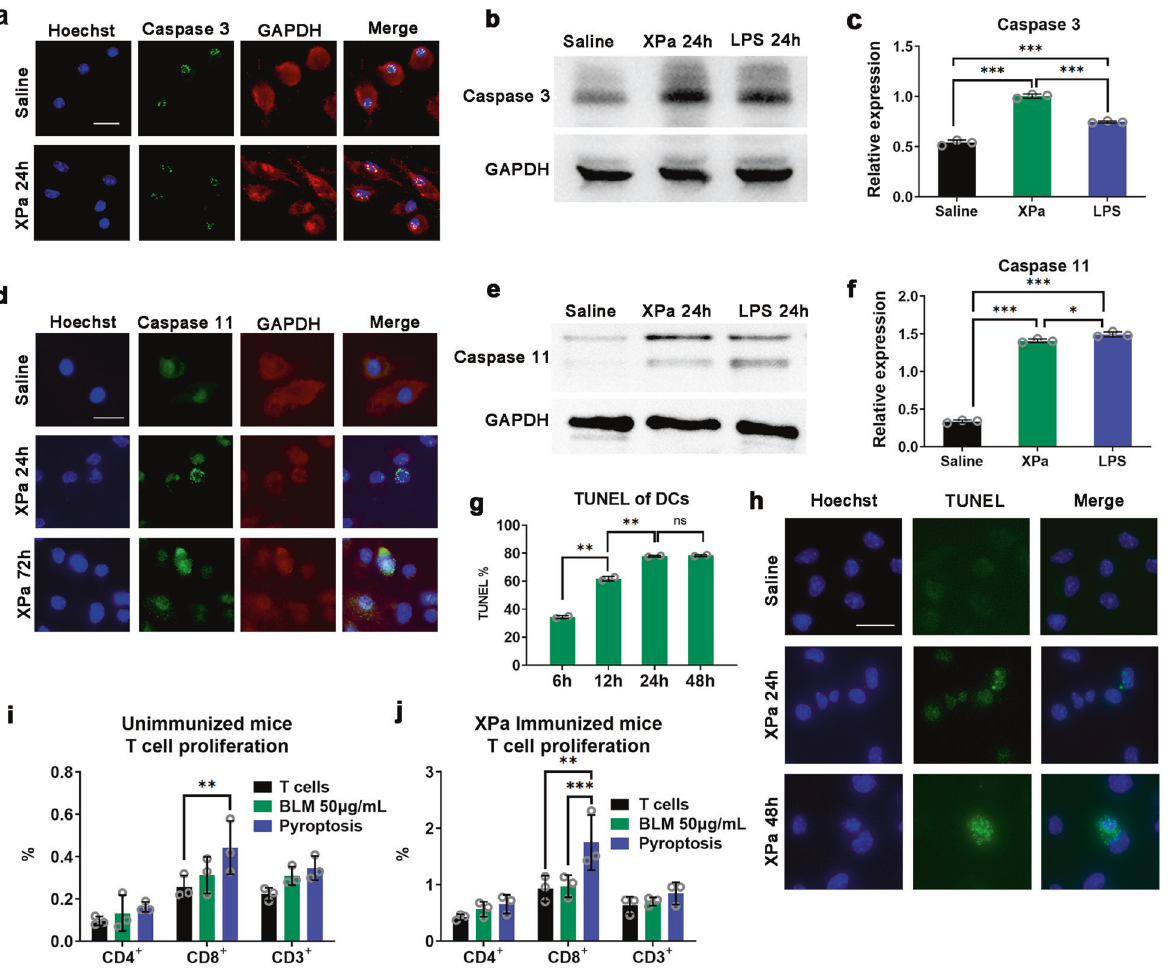
Fig. 5 Fate of DCs after XPa immunization in vitro. a Immuno fl uorescence of caspase 3 in XPa (10 MOI)stimulated BMDCs after 24 h. b and c WB of caspase 3 in RAW264.7 cells treated with saline, LPS (100 ng/mL), and XPa (10 MOI) for 24 h; n = 3. d Immuno fl uorescence of caspase 11 in XPa (10 MOI) stimulated BMDCs after 24 h and 72 h. e and f WB of caspase 11 in RAW264.7 cells treated with saline, LPS (100 ng/mL), and XPa (10 MOI) for 24 h; n = 3. g TUNEL staining of XPa (10 MOI) stimulated BMDCs after 24 h and 48 h. h DCs were stimulated with XPa (10 MOI) for 6, 12, 24, or 48 h and subjected to TUNEL staining (One step TUNEL test kit, Beyotime, C1086). Flow cytometry analysis of TUNEL results; n = 2. ns = no signi fi cant difference. i and j DCs were treated with BLM (bleomycin, 50 μ g/mL) for 24 h, and pyroptosis was induced (the DCs were aspirated into a syringe, and plunger movements were repeated 10 times). DCs were cocultured with CD3 + T cells from the spleens of unimmunized mice or XPa-immunized mice for 72 h. The proliferation of T cells was evaluated using CFSE staining. Scale bars, 20 μ m. Data were analyzed via two-way ANOVA. * P < 0.05, ** P < 0.01, *** P < 0.001. No letter is present if no signi fi cant difference was (log10 2.62 ± 0.51) and COPD + XPa (log10 2.29 ± 1.23) groups indicate that the cGAS-STING pathway mediates the immune decreased (** P < 0.01) compared to that in the COPD group (log10 response elicited by XPa in mice. 4.27 ± 0.84), which hinted at the potential for clinical application P. aeruginosa is very dif fi cult to prevent and treat due to its multidrug resistance. Thus, we repeated the experiments using the clinically isolated multidrug-resistant P. aeruginosa W9 (serotype O20) (Fig. 7c). Lower-lung W9 load was found in mice immunized (log10 4.74 ± 0.95) with XPa than those in unim- munized mice (log10 6.03 ± 0.33) ( P < 0.01). This result suggests that XPa was able to overcome the drug resistance of bacterial pathogens and protected mice from challenge with the hetero- logous serotype W9 (PAO1 was serotype O2/O5). COPD mice immunized with XPa could resist PAO1 infection P. aeruginosa is detectable in the airways of approximately 25 – 50%